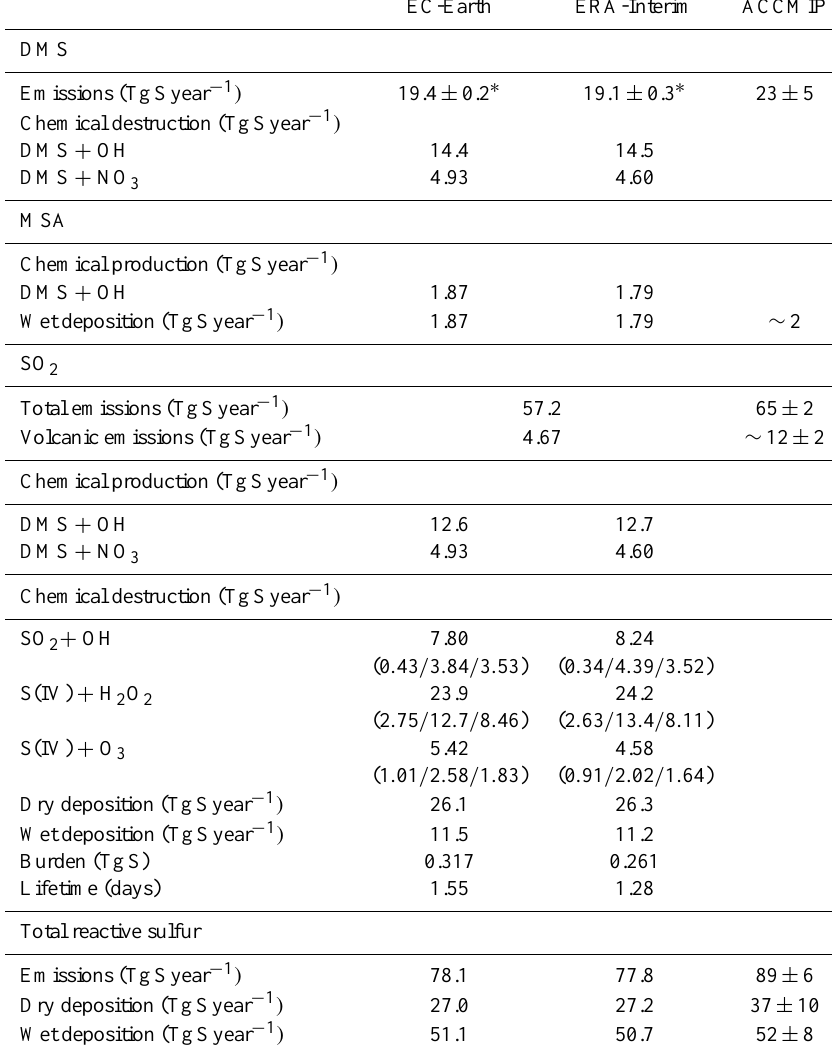
Table A6. Global budgets of DMS, MSA, SO 2 and total reactive sulfur together with the global burden and lifetime of SO 2 for the reference EC-Earth simulation and the corresponding ERA-Interim simulation. For comparison we have also included ACCMIP multi-model means and standard deviations of emissions and depositions for the year 2000 from Lamarque et al. (2013b). For the gas-phase SO 2 and aqueous- phase S(IV) oxidation reactions, which result in the production of SO 4 , the numbers between parentheses give the separate contributions from 90–30 ◦ S, 30 ◦ S–30 ◦ N, and 30–90 ◦ N.